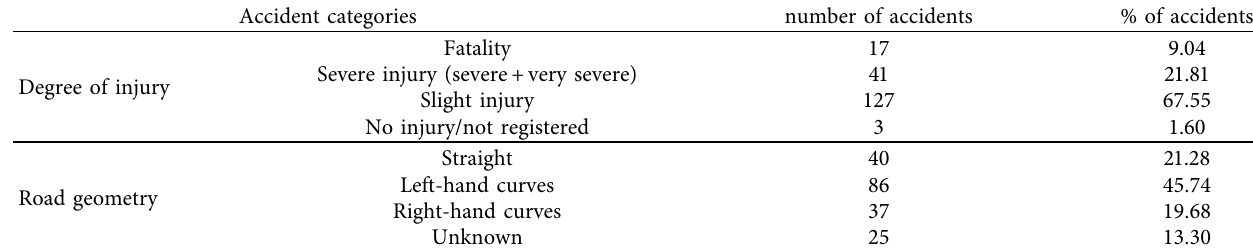
Table 3: Descriptive statistics on accidents.